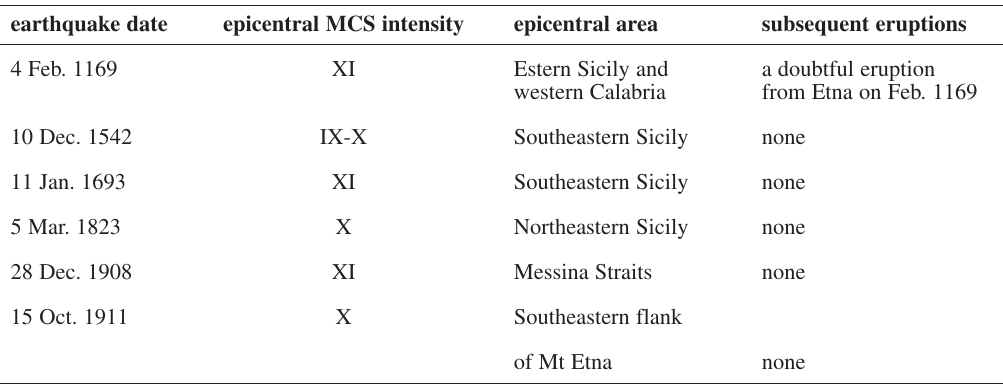
Table I. Largest historical earthquakes of Sicily and southern Calabria (southern Italy, fig. 1) and subsequent eruptions at Etna, Stromboli, and Vulcano. Data are from Simkin and Siebert (1994) and from Boschi et al.